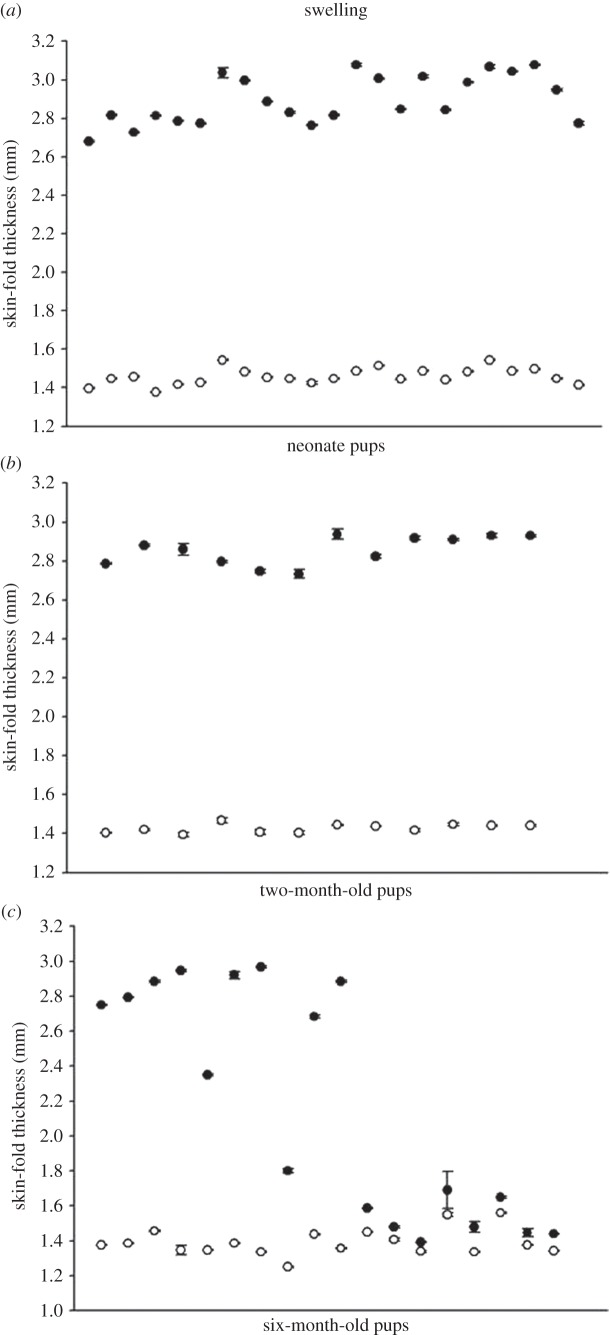
Comparison of swelling in PHA-injected (closed circles) and saline-injected (open circles) flipper webs of (a) neonate, (b) two-month-old, and (c) six-month-old California sea lion pups. Graphs show individual data points (raw data) for the median of the three flipper measurements for each pup ±1 s.e.